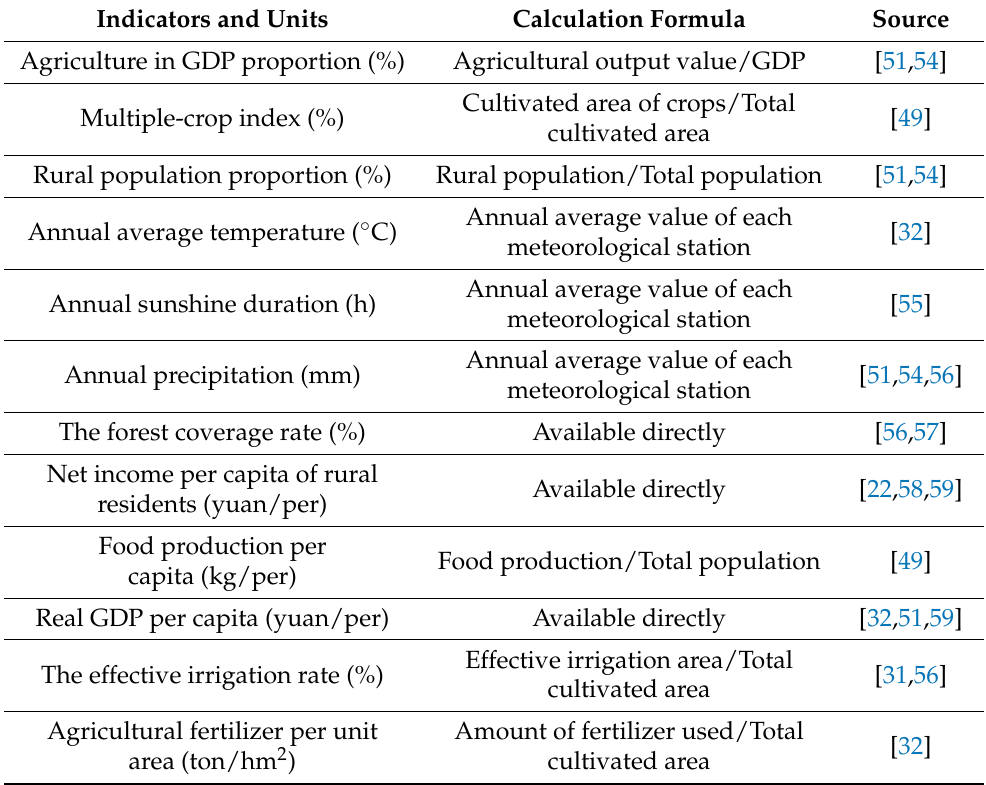
Table 1. Index system and source of China’s agricultural drought vulnerability assessment.